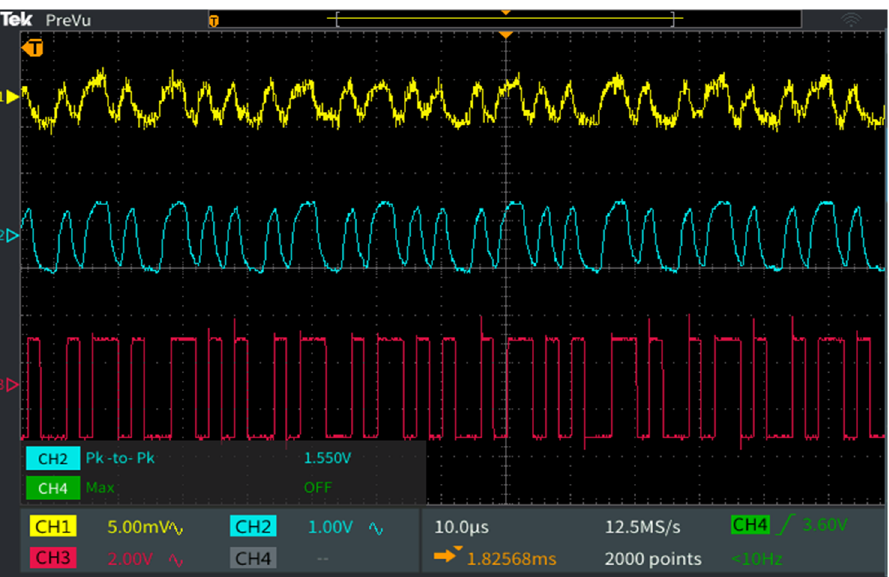
Figure 10. Oscilloscope screen showing the signal processing plan at the VLC receiver level: Channel 1 (yellow) shows the output of the transimpedance amplifier adjusted at 10 dB gain; Channel 2 (cyan) provides the output of the amplified signal, after 1 kHz–1 MHz band-pass filter that will be feed into the Schmitt trigger circuit; Channel 3 (magenta) displays the final data signal that will be provided to the microcontroller for the data extraction process.